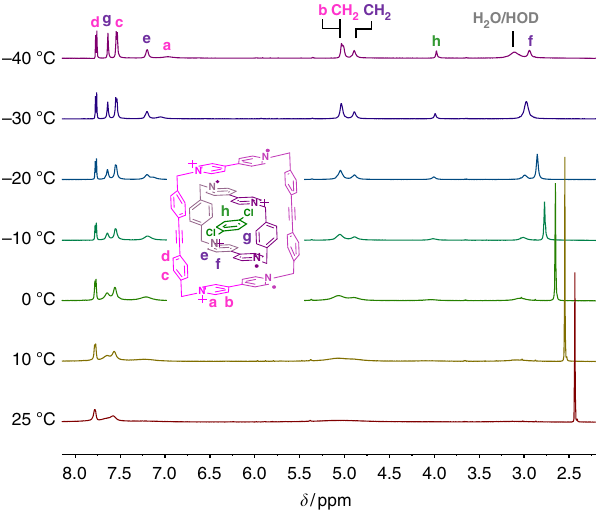
Fig. 7 VT-NMR studies of [ p -C 6 H 4 Cl 2 ⊂ CBPQT ⊂ 1 ] 4( + (cid:129) ) 1 H NMR Spectra recorded from − 40 to + 25°C for a 1:1:1 molar mixture of CBPQT 2( + (cid:129) ) , 1 2( + (cid:129) ) and 1,4-dichlorobenzene (1.0 mM each) in CD 3